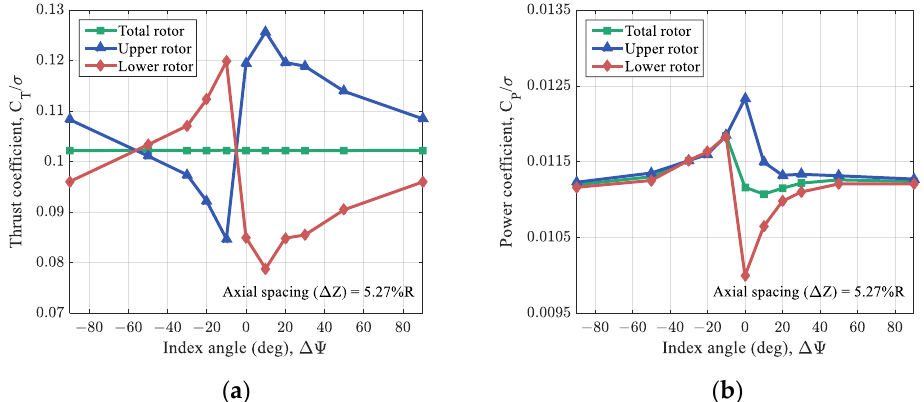
Figure 12. Hover performance analyses in terms of index angle ( C T = 0.0102): ( a ) Thrust ( C T / σ ); ( b ) power ( C P / σ ).